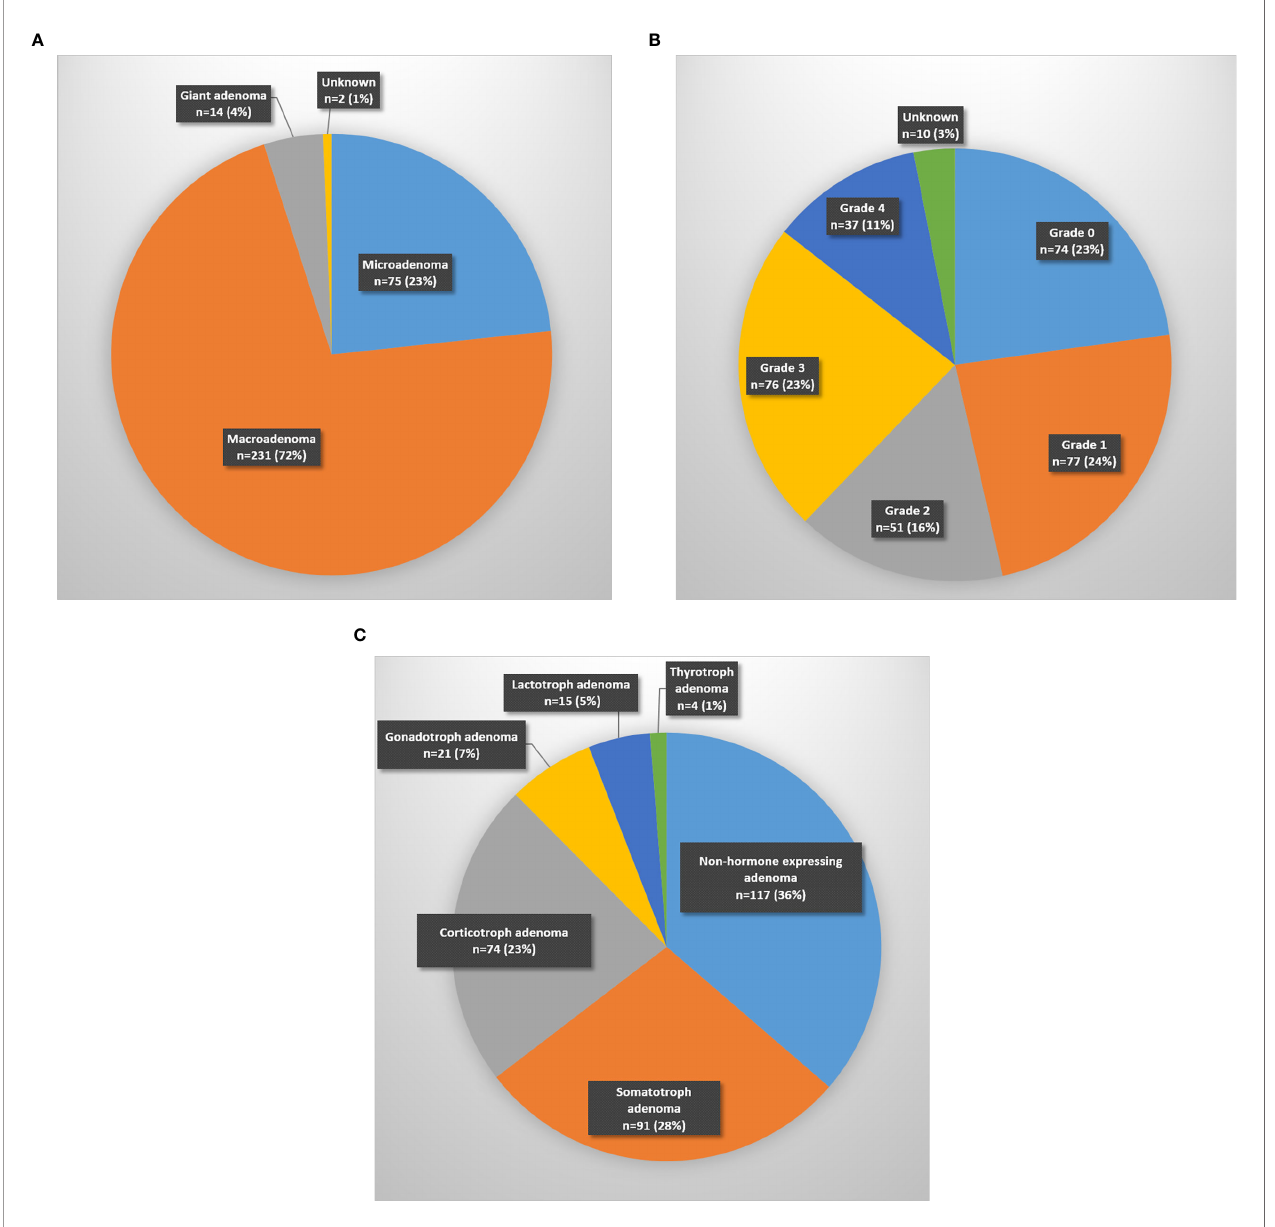
FIGURE 2 | Distribution of pituitary adenomas according to (A) size (micro < 10 mm; macro 10 – 40 mm; giant > 40 mm), (B) Knosp classi fi cation-grade, (C) main hormone expression